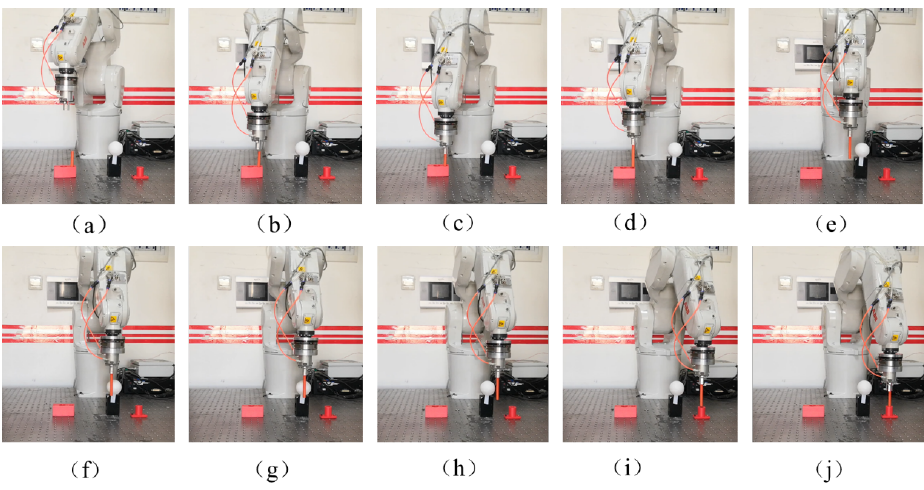
Figure 10. Path planning process for the manipulator with the GMM/GMR-MPRM algorithm. ( a – j ) are the different stages of the manipulator in completing the